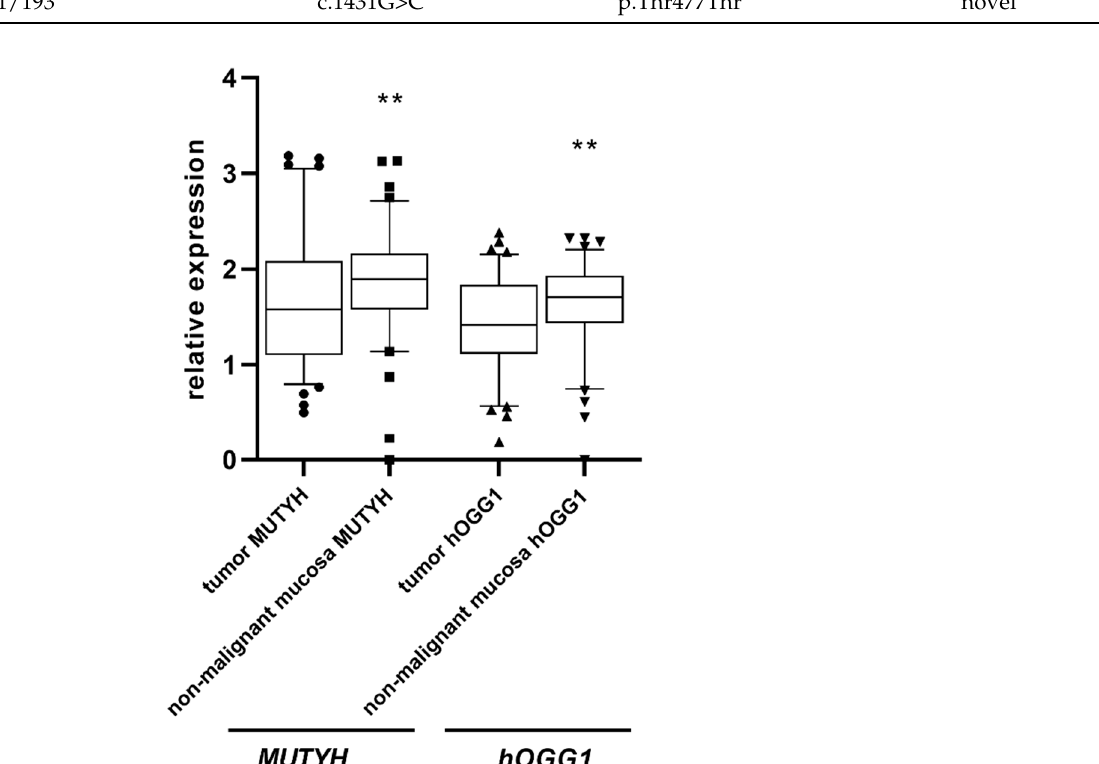
Figure 2. ( A , B ). MUTYH and hOGG1 relative gene expressions significantly correlated in both tumor (rho = 0.599, p ˂ 0.001) and adjacent mucosa (rho = 0.638, p ˂ 0.001; n = 91).